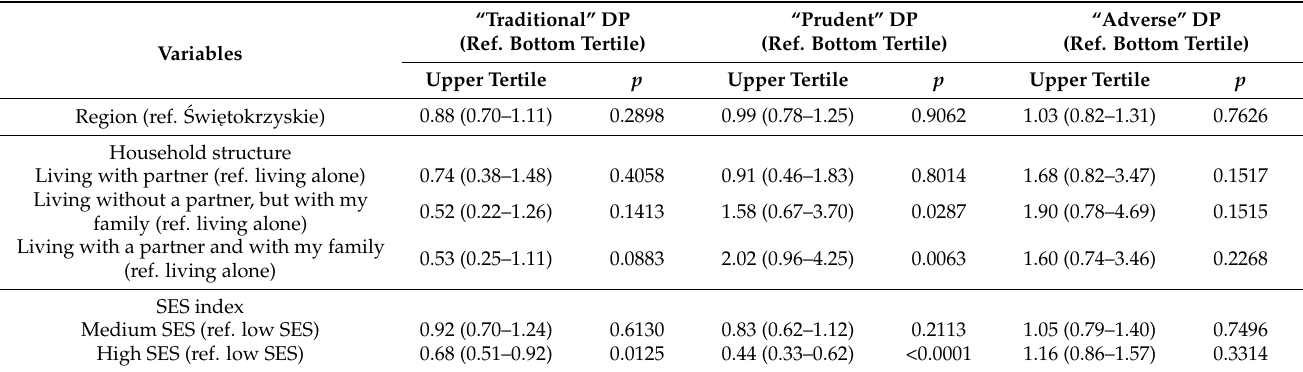
Table 4. Associations between dietary patterns and region, household structures and SES index in the study sample (adjusted odds ratios with 95% confidence intervals). “Traditional” DP “Prudent” DP “Adverse” DP (Ref. Bottom Tertile) (Ref. Bottom Tertile) (Ref. Bottom Tertile) Variables Upper Tertile p Upper Tertile p Upper Tertile p Region (ref.